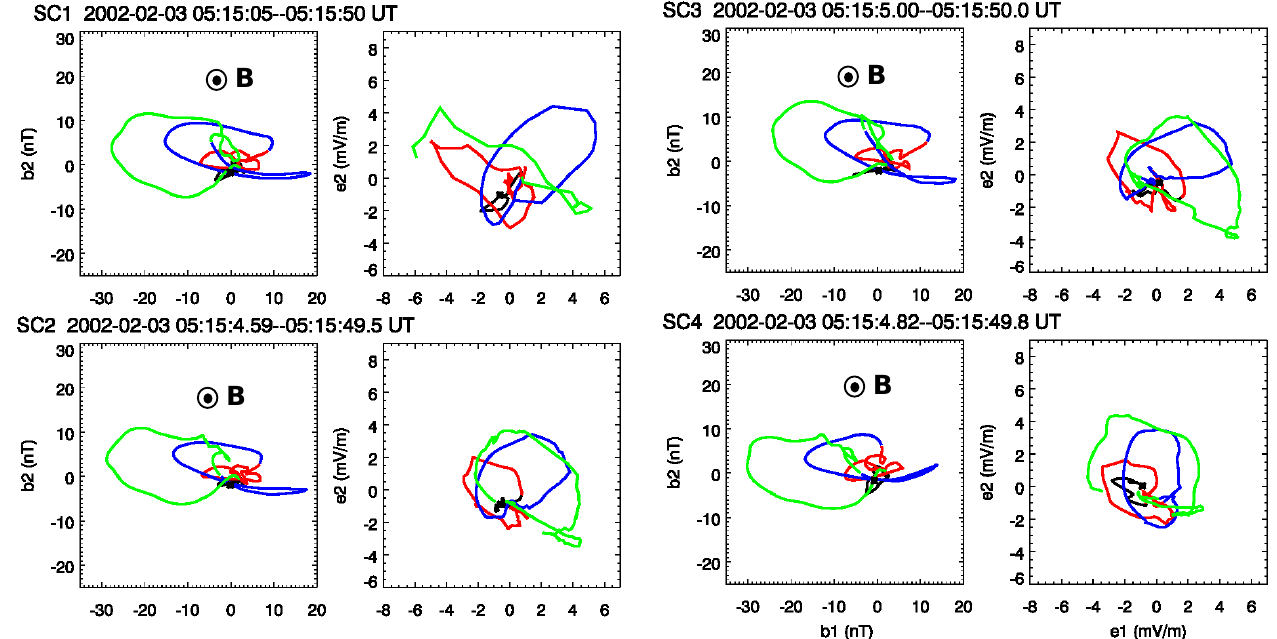
Fig. 4. Polarization of the waves with respect to the ambient magnetic field for interval A, plotted in the same format as that of Fig. 3. The magnetic field is out of the